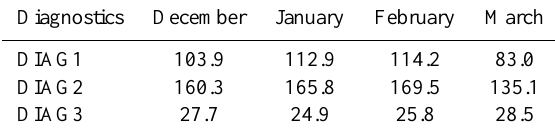
Table 2. Percentage mean change in DIAG1, DIAG2, DIAG3 for zonally averaged CDNC burden over 30S-75S latitudinal belt.